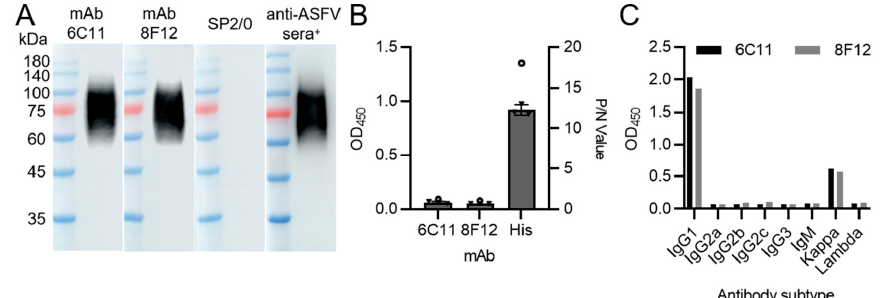
Figure 1. Production and characterization of two CD2v protein ‐ specific mAbs. ( A ) Western blotting results of mAbs 6C11 and 8F12 reaction against CD2v ‐ ex protein. SP2/0 cell supernatants and posi ‐ tive anti ‐ ASFV sera (anti ‐ ASFV sera + ) were used as negative and positive controls, respectively. ( B ) Indirect ELISA results of mAbs 6C11 and 8F12 reaction against p30 protein with His ‐ tag. His mAb was used as positive control. Data are presented as mean ± SD. ( C ) Isotype determination of mAbs 6C11 and 8F12.